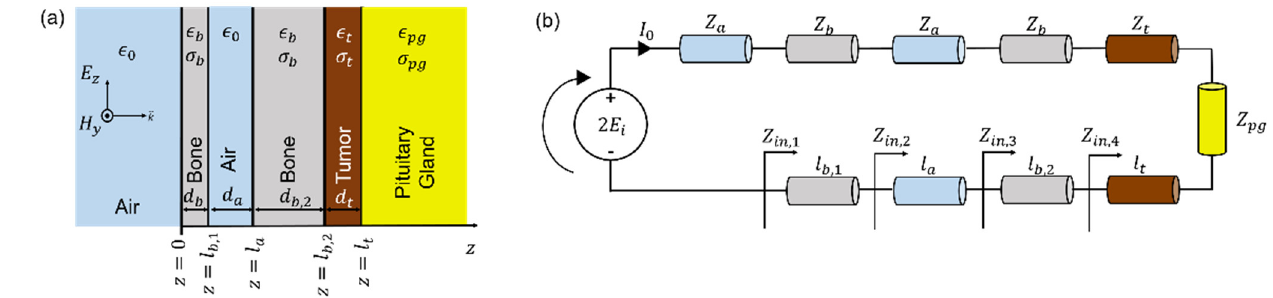
Figure 2. ( a ) Simplified mono-dimensional geometry for the propagation model considered for the proposed trans-sphenoidal microwave diagnostic approach. ( b ) Transmission line equivalent model for the solution of the forward problem.